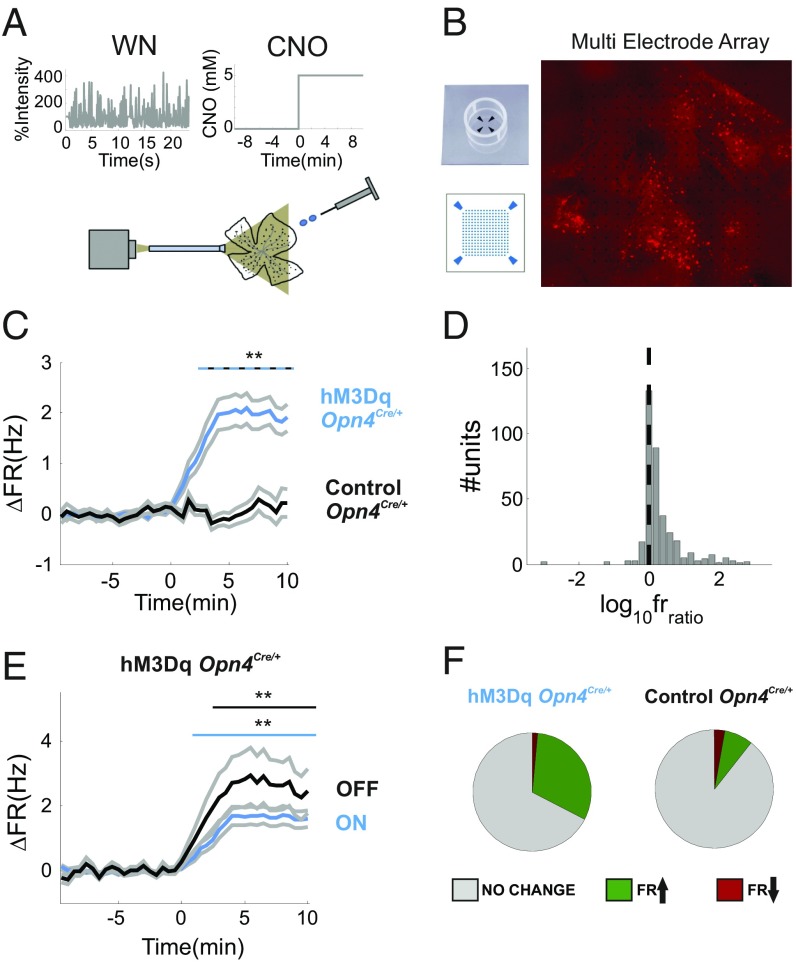
Chemogenetic activation of ipRGCs enhances maintained firing across the RGC population. (A) Schematic of our visual-chemogenetic stimulus. A white-noise (WN) stimulus was presented at constant mean irradiance (11.5 log10 photons⋅cm−2⋅s−1) with timed CNO delivery. (B) Representative image for a whole-mount retina rec orded under our MEA system. mCherry fluorescence spanning large regions of the recording array could be observed. (C) Mean ± SEM change in time-averaged firing rate (ΔFR over mean before CNO administration) for hM3Dq-expressing (blue line) and control (black line) retinas following CNO application (5 µM) commencing at time 0. The top blue-black dashed line indicates significant differences in ΔFR (**P < 0.01, rank sum tests, Bonferroni’s correction). (D) The distribution of logarithmic ratios between firing rates (log10frratio) from hM3Dq-expressing retinas, before and after CNO delivery, is unimodal, and most units express an increase in firing rate (log10frratio > 0). (E) As in B, plotting ON and OFF units from hM3Dq retinas (lines above indicate significant increases in firing; P < 0.01, sign rank tests, Bonferroni’s correction). (F) Pie charts presenting percentage of units that showed increase, decrease, or no change in firing rate upon CNO application in hM3Dq (Left) and control (Right) retinas.